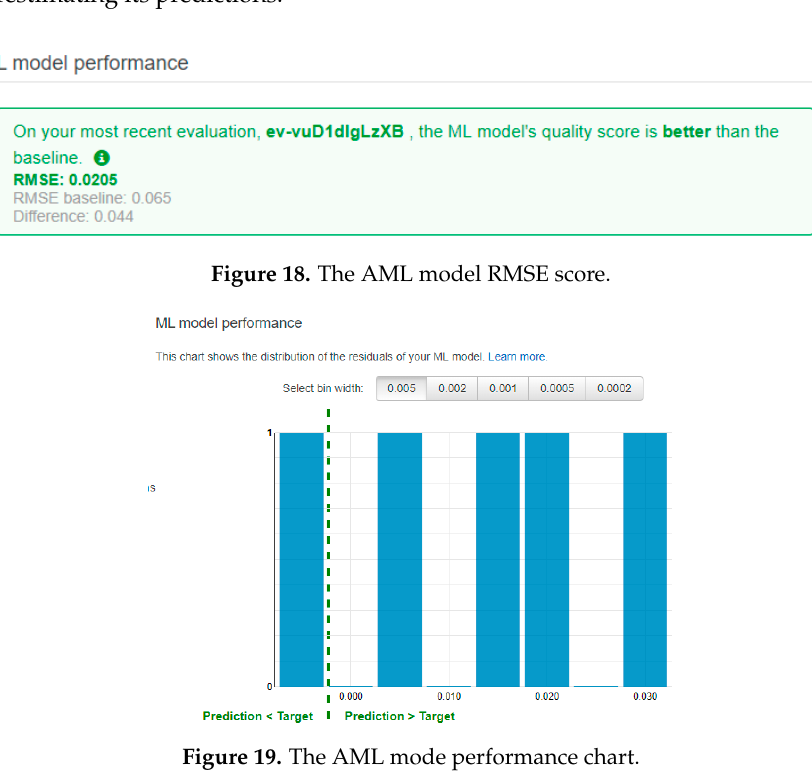
Figure 19. The AML mode performance chart.